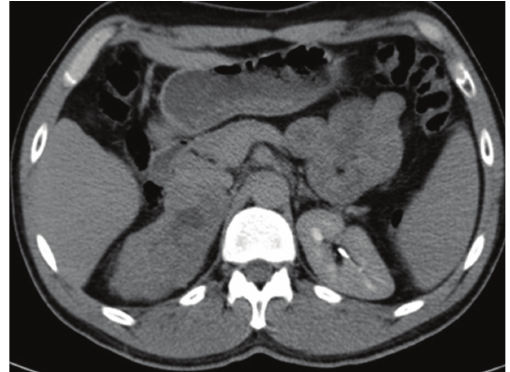
Figure 5: Axial CT at the delayed phase shows more or less homoge- nous enhancing with nonenhancing central scar